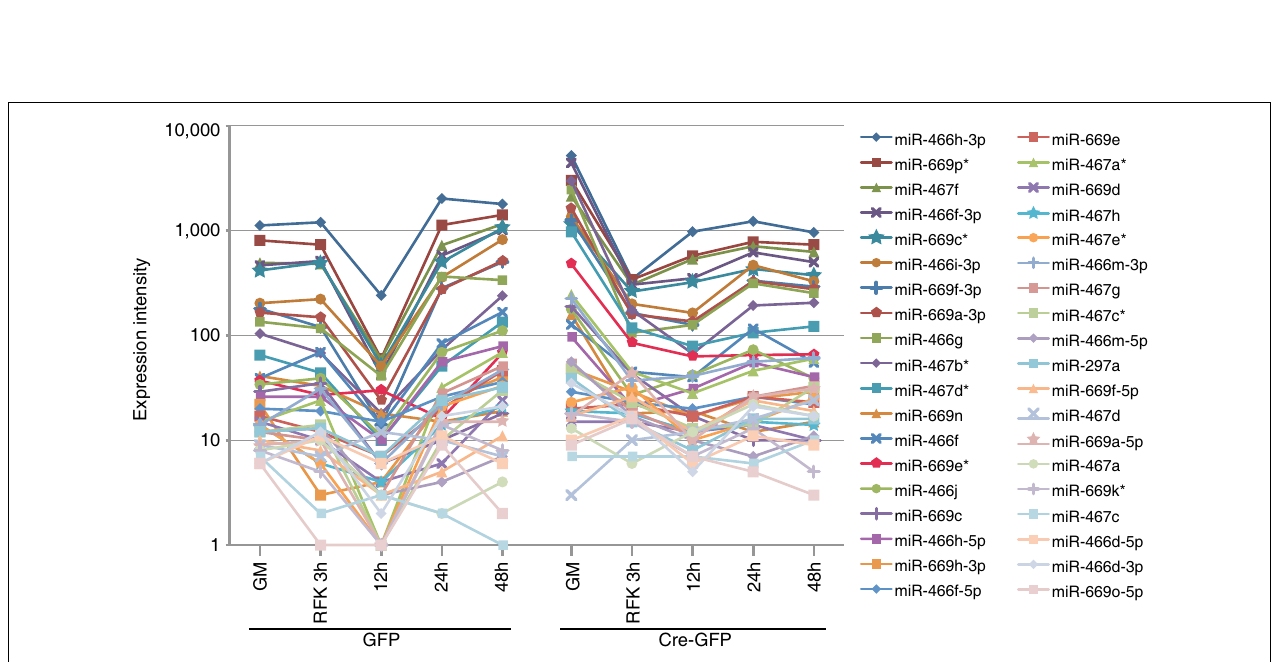
FIGUREA3 | Expression distribution of miRNAs examined in the array analysis. The top expressed miRNAs account for the majority of the total miRNA expression: about 6% with an expression value between 500 and